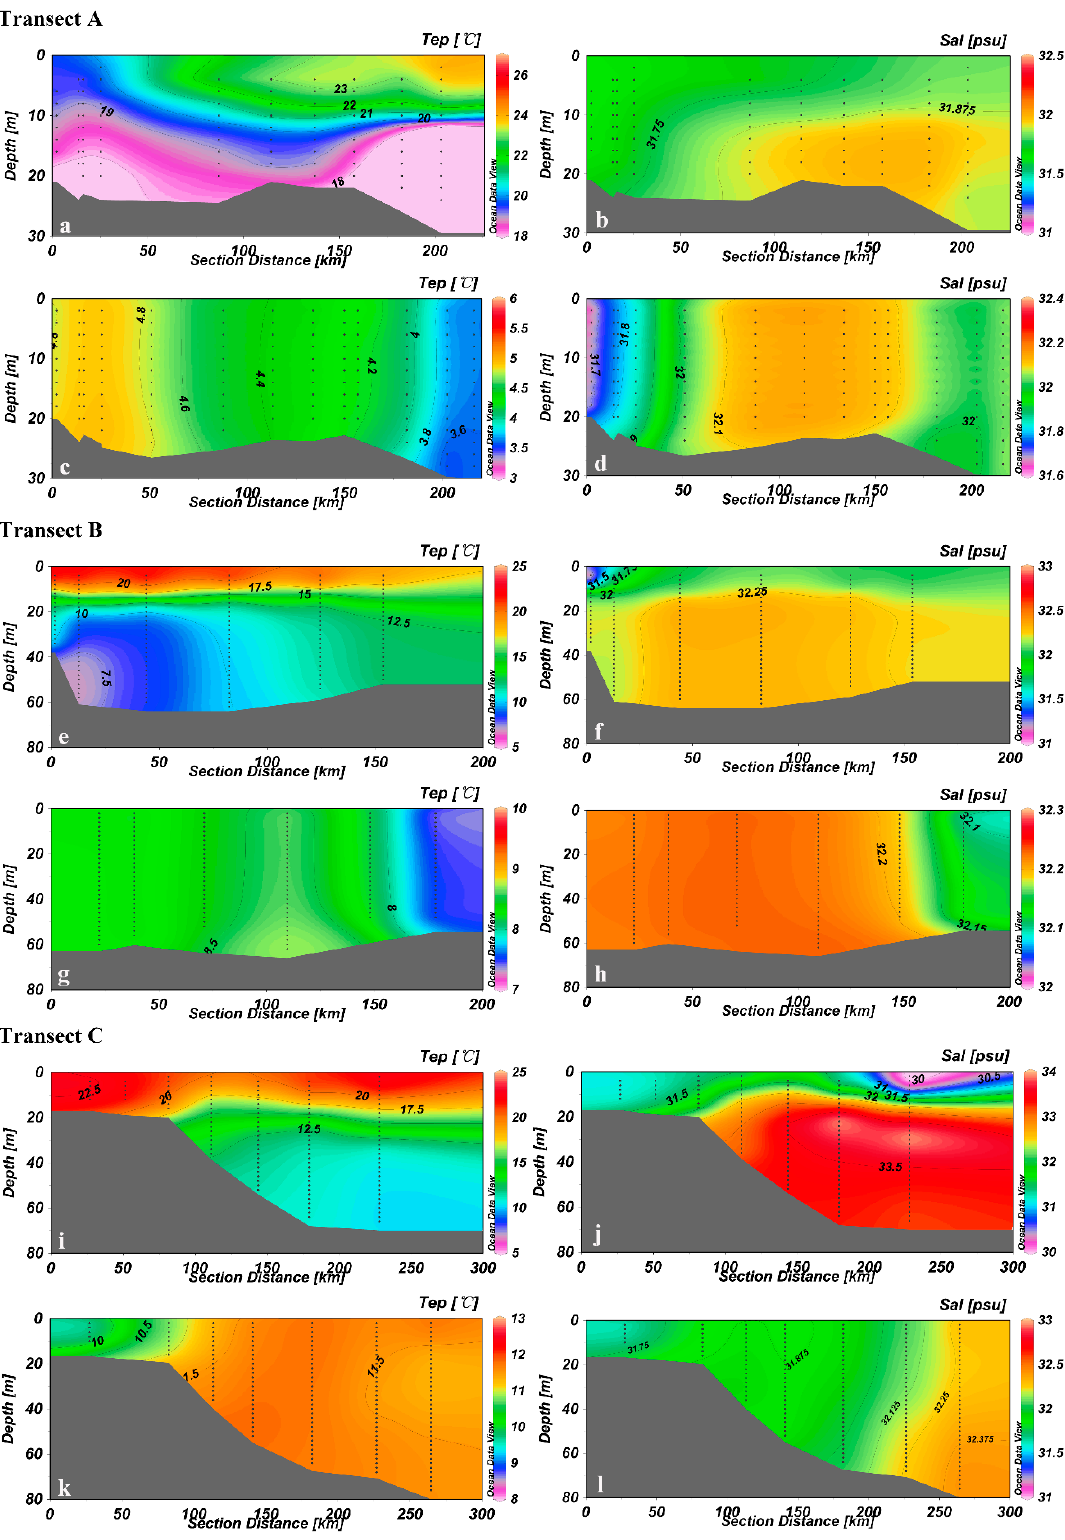
Figure 3. Distributions of temperature and salinity: ( a – d ) are transect A, ( a , c ) are the temperature in summer and winter, respectively; ( b , d ) are the salinity in summer and winter, respectively. ( e – h ) are transect B, the sequence is the same as that on transect A; ( i – l ) are transect C, the sequence is the same as that on transect